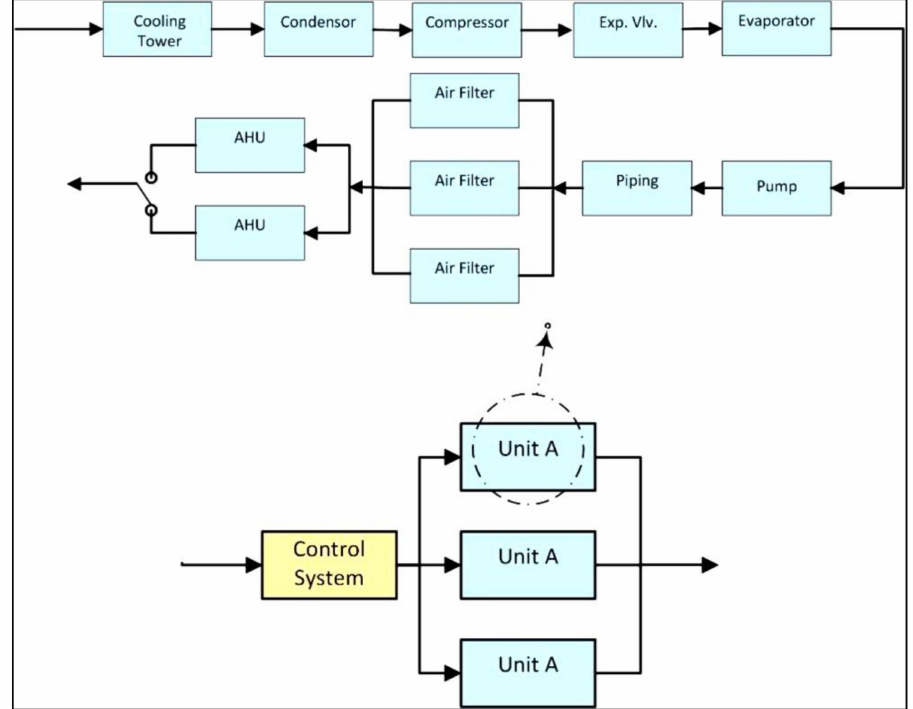
Figure 2. The system’s diagram. The arrow shows that each Unit A is a cooling unit and it is expanded to a subsystem shown above the